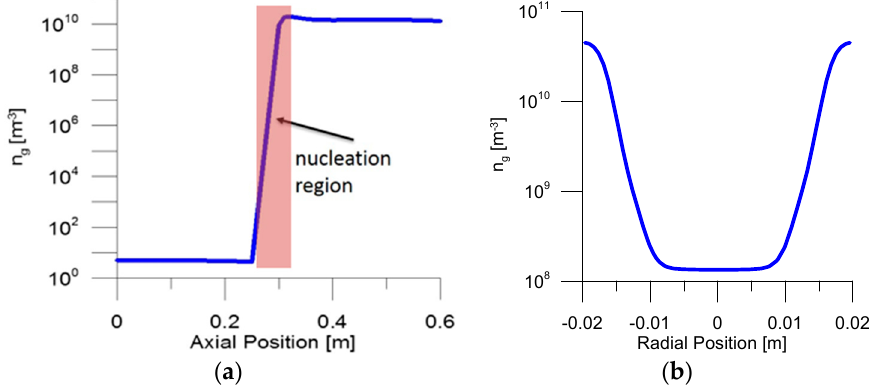
Figure 8. Distribution of bubble number density in ( a ) the axial direction and ( b ) the radial direction at x = 0.458 m.